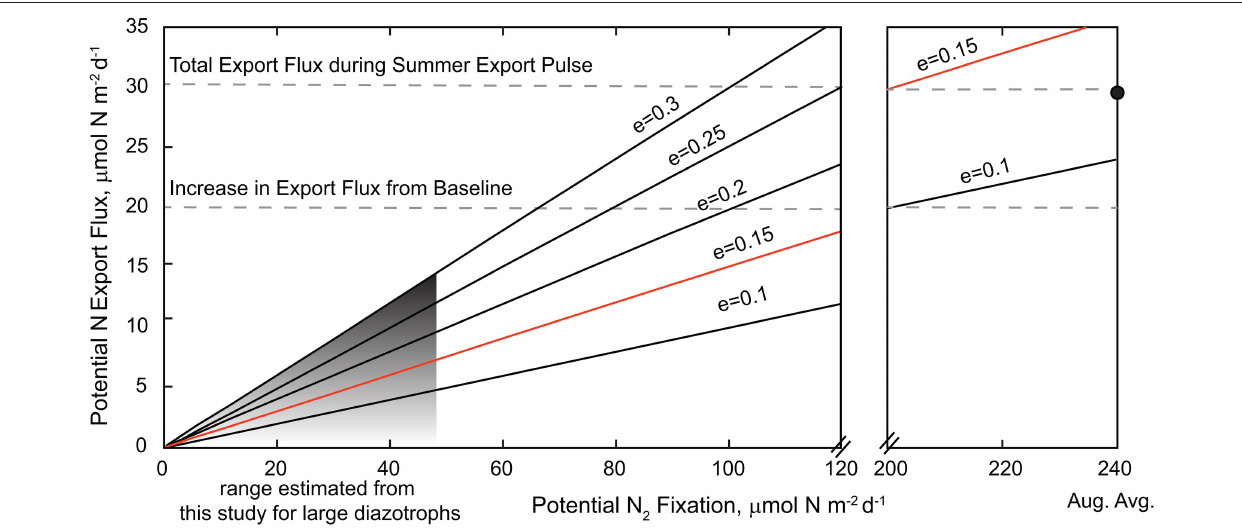
FIGURE 5 | Relationship between potential N 2 fixation rates and deep-sea export; note the scale break between 120 and 200 µ mol N m − 2 d − 1 . The range of N fixation estimated to be fueled by large diazotrophs ( Trichodesmium + DDA’s) in the upper 45m of the water column at Station ALOHA (2015–2016) is shown in gray ( ∼ 1–46 µ mol N m − 2 d − 1 ). The total water column integrated mean N fixation rate for August ( ∼ 240 µ mol N m − 2 d − 1 ) is shown as a filled circle. Potential N export is calculated as a function of potential N 2 fixation rates and export ratios ranging from 0.1 to 0.3. The upper range of export ratios (0.15) measured at Station ALOHA is shown in orange. The magnitude of the increase in export flux during the summer export pulse and the total flux are shown as dashed lines. Note that the baseline export flux at Station ALOHA is ∼ 10 mmol N m − 2 d − 1